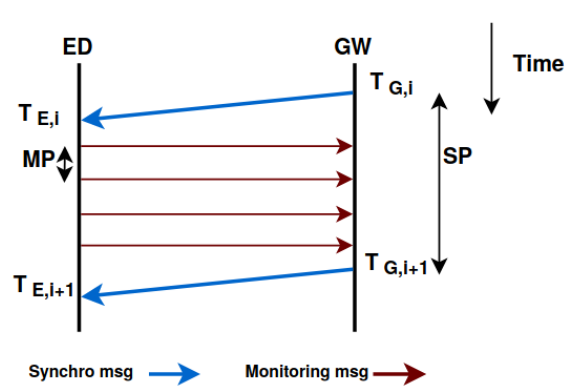
Figure 9. Time diagram of synchronization and